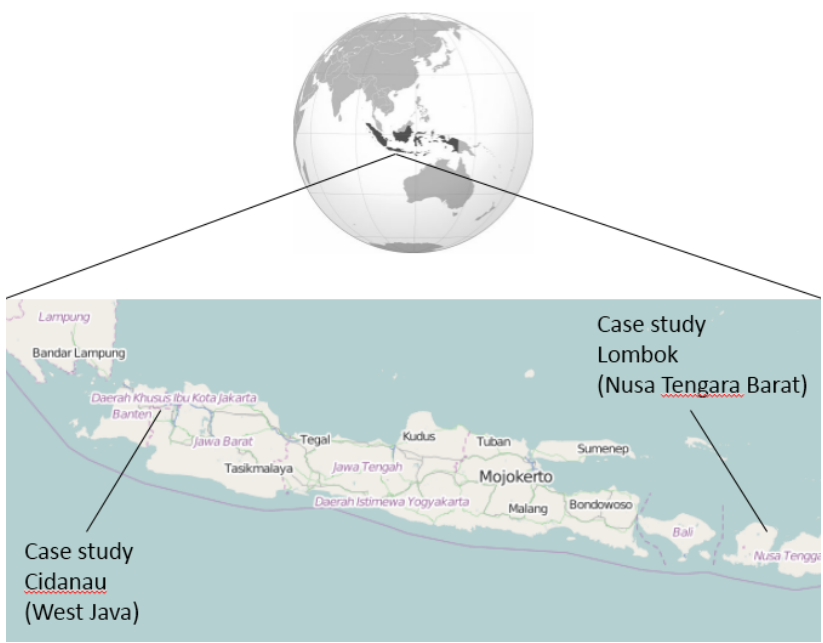
Figure 1. Location of the two case studies